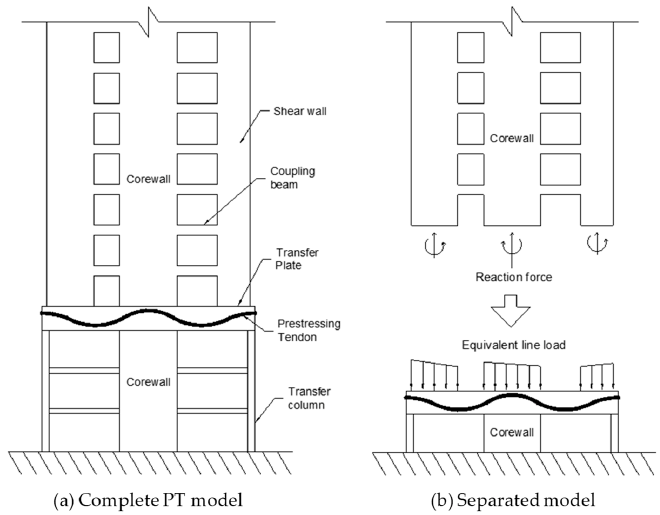
Figure 7. Concept of two analysis modeling methods.